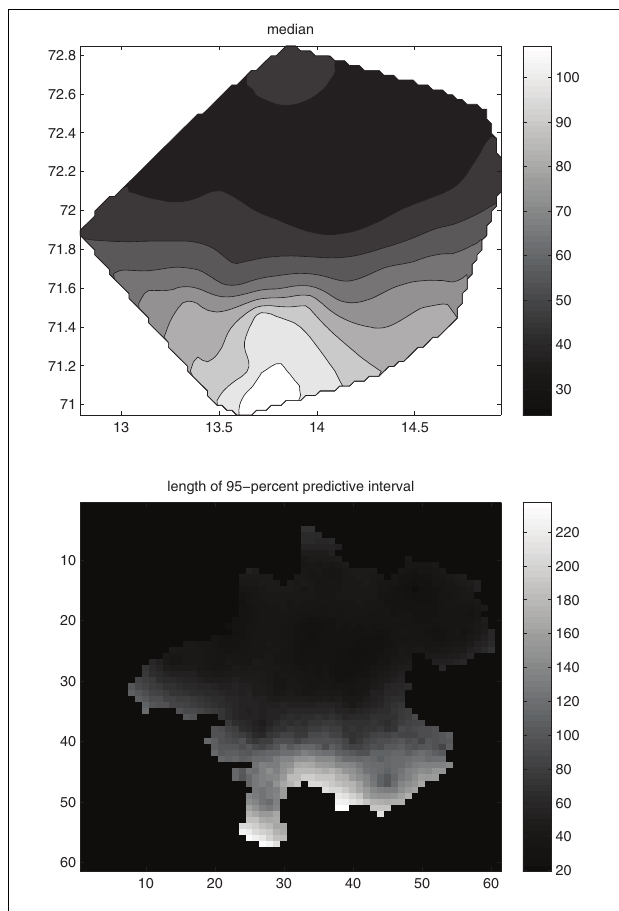
FIGURE 13 | Above: The predictive median of the mean residual rainfall field 53 calculated from the predictive distributions of trans-Gaussian kriging + applied to the 36 means of rainfall residuals 53. Below: Lengths of estimated + 95 % predictive intervals corresponding to the trans-Gaussian kriging from the upper